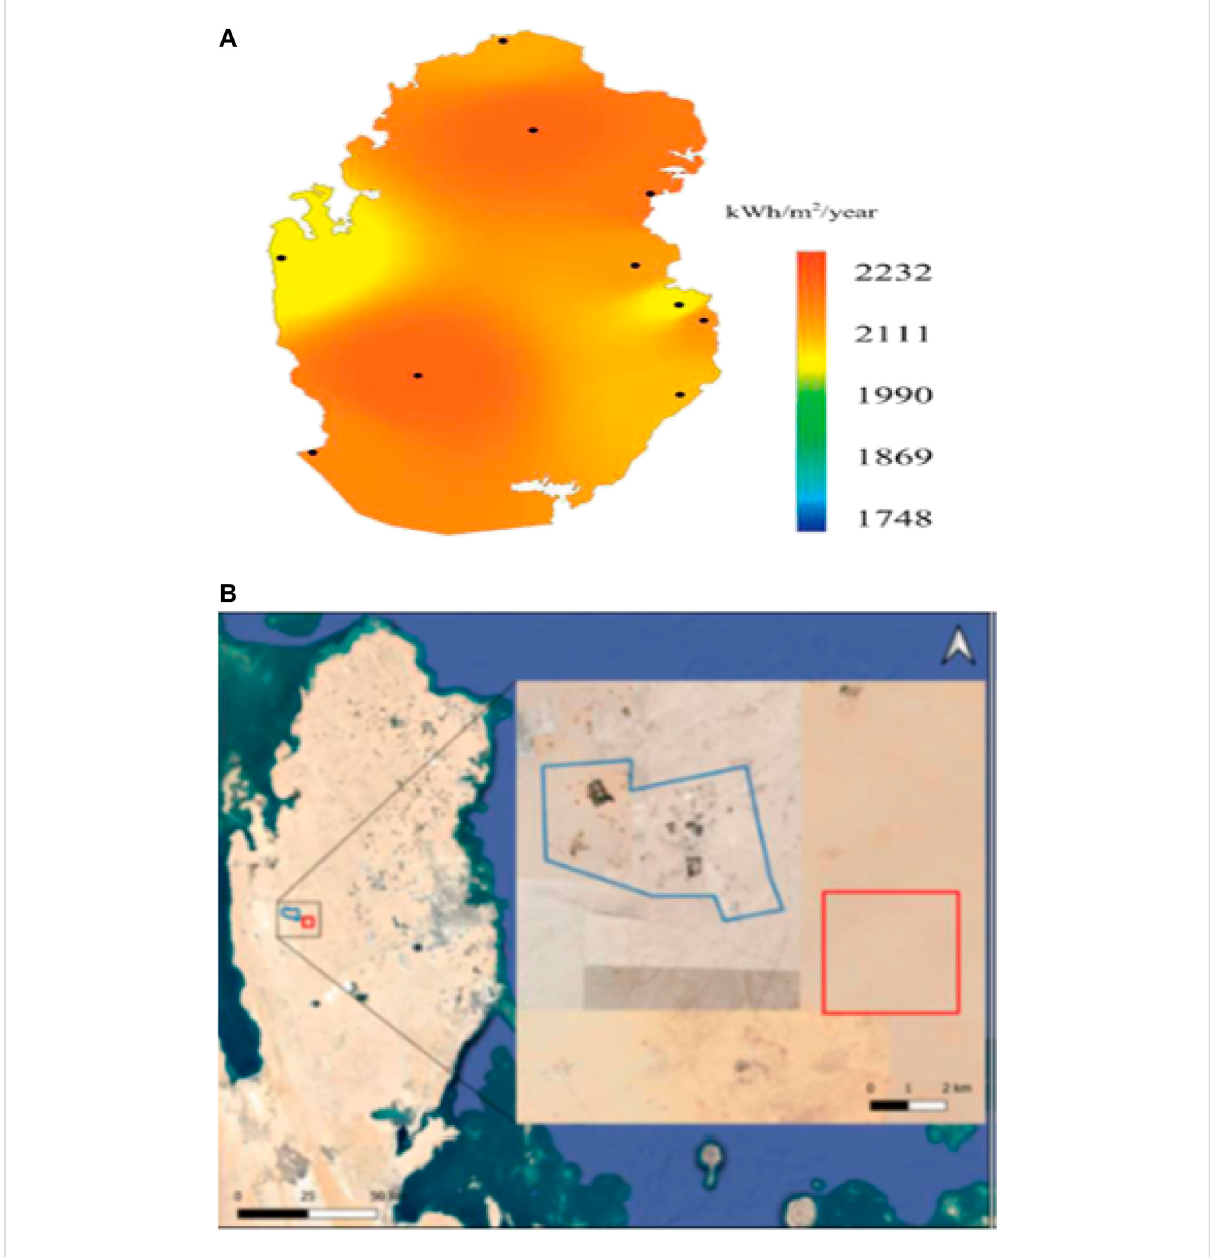
deployment in the GCC